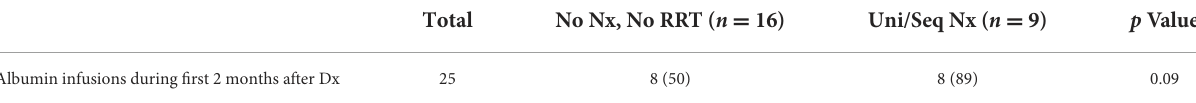
TABLE 5A Albumin infusions in children with CNS and INS who did not require interventions (Nx or RRT) vs . those who underwent Unilateral/Sequential nephrectomy.